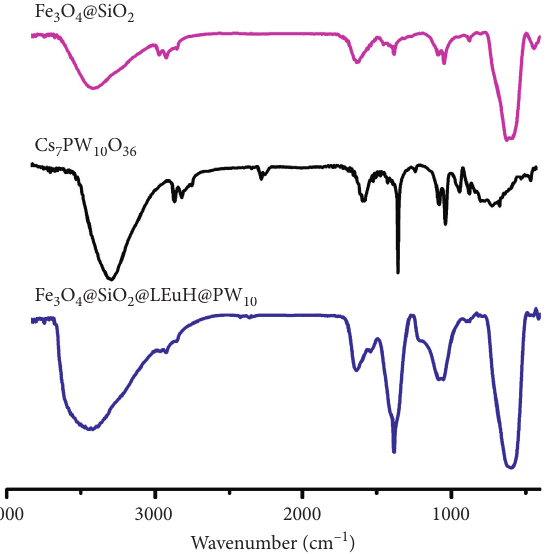
3 O 4 @SiO 2 @LEuH@